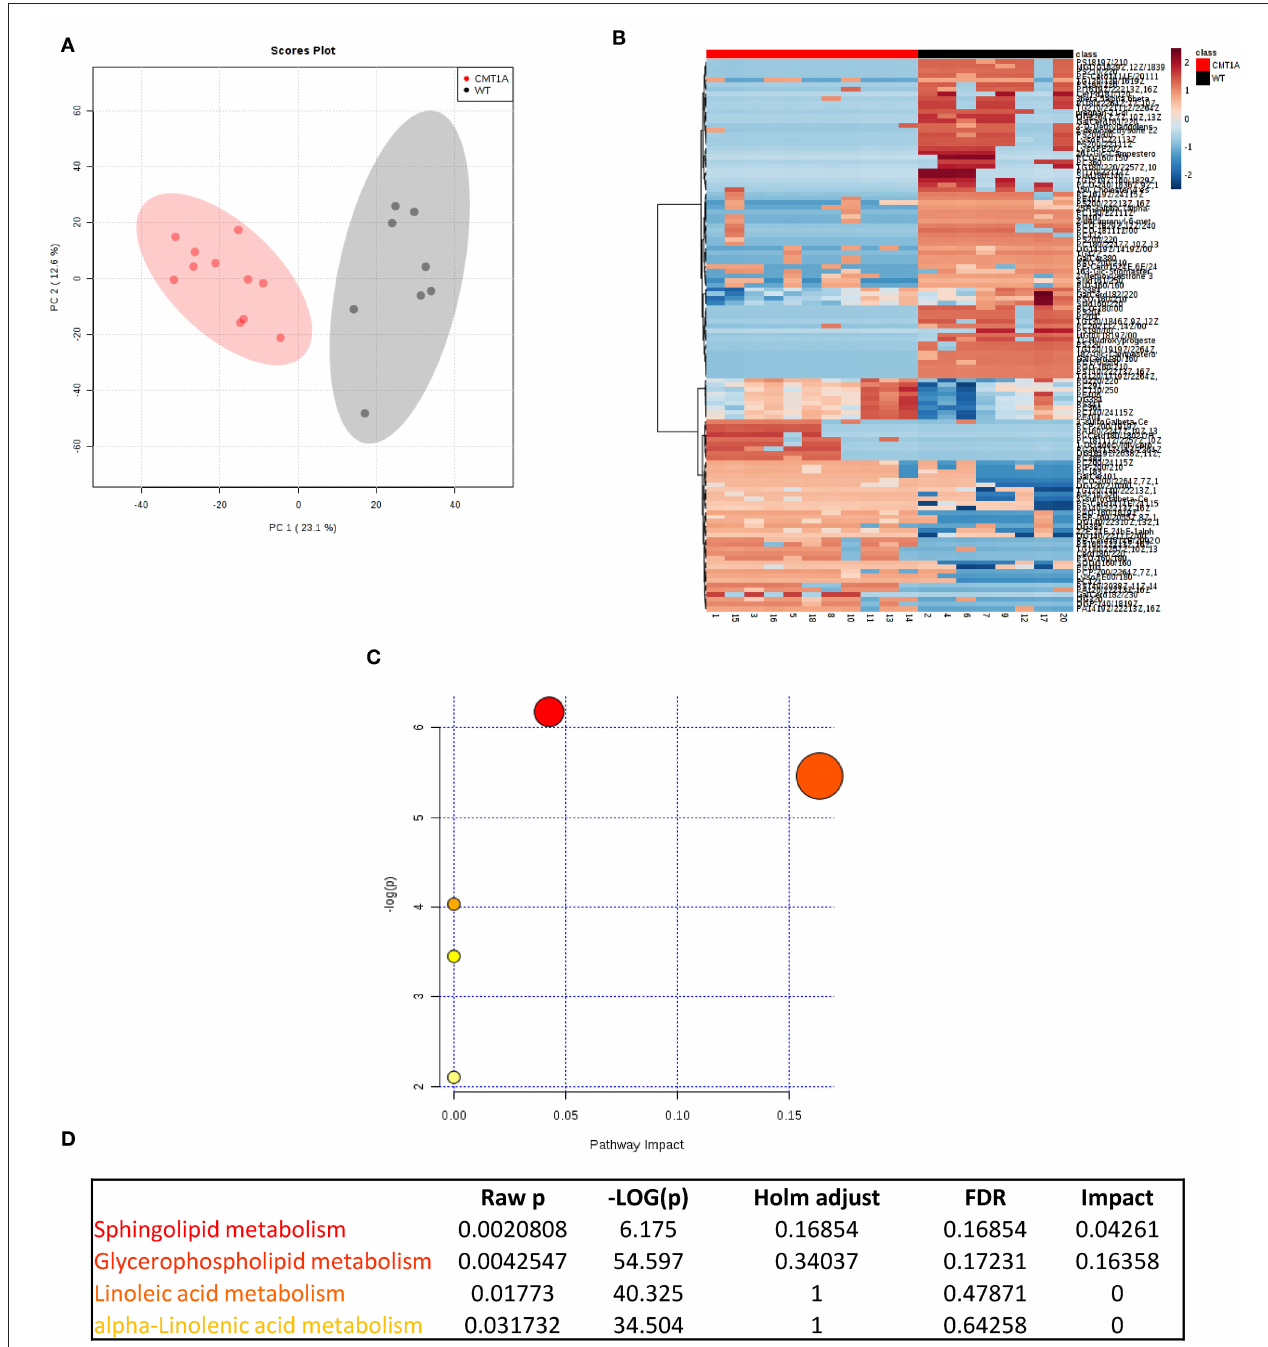
FIGURE 1 | Multivariate data analysis (MVA) of rat sciatic nerve lipidome clearly discriminates CMT1A from controls displaying a specific impairment of sphingolipid and glycerophospholipid metabolism. (A) Score plot from principal component analysis (PCA) of untargeted lipidomics data. PCA was able to reliably discriminate CMT1A nerves (red, n = 11) from the wild type ones (black, n = 8). (B) Heatmap generated with the most significant features (with highest fold change and statistical significance) detected by MVA. One hundred twenty-one features were mainly responsible for the difference between the two groups. (C) Graph presenting the probability (y-axis) and the impact (x-axis) that a pathway is responsible for the difference shown in lipidomic profiles. Each circle represents a specific lipid pathway; the circle size represents the number of hits per pathway. Red–orange–yellow–white diminishing scale represents the degree of involvement in lipidomic profiles. (D) Table indicating only the significant pathways presented in the